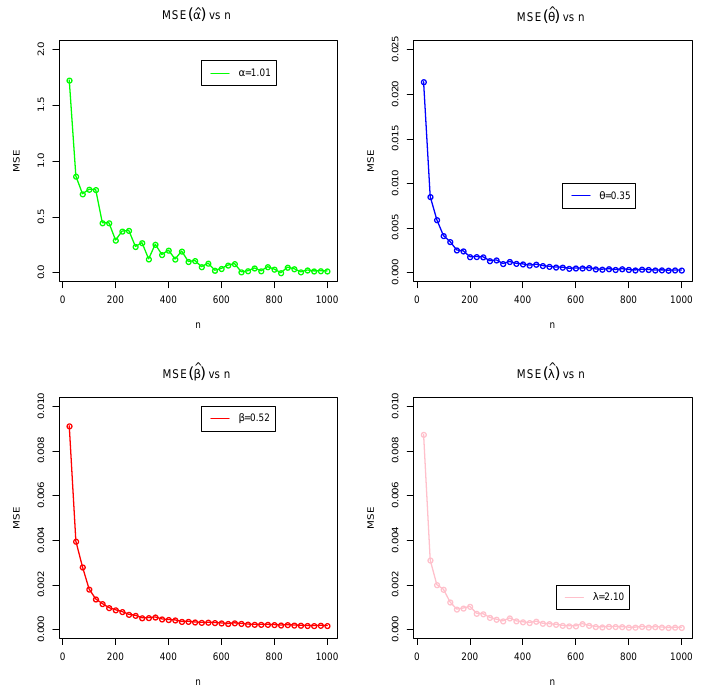
Figure 4. For set 1, MSE plots of GAEPPRD : α = 1.01, θ = 0.35, β = 0.52, λ = 2.10.